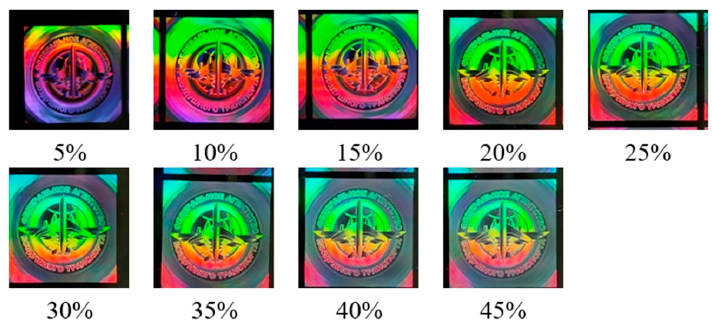
Figure 6. Main image of the hologram (exposure fitting).